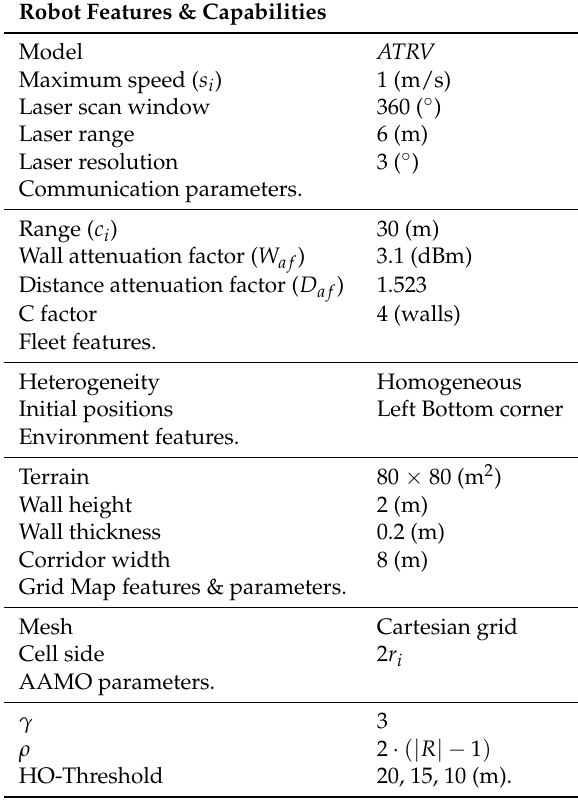
Table 3. Simulation